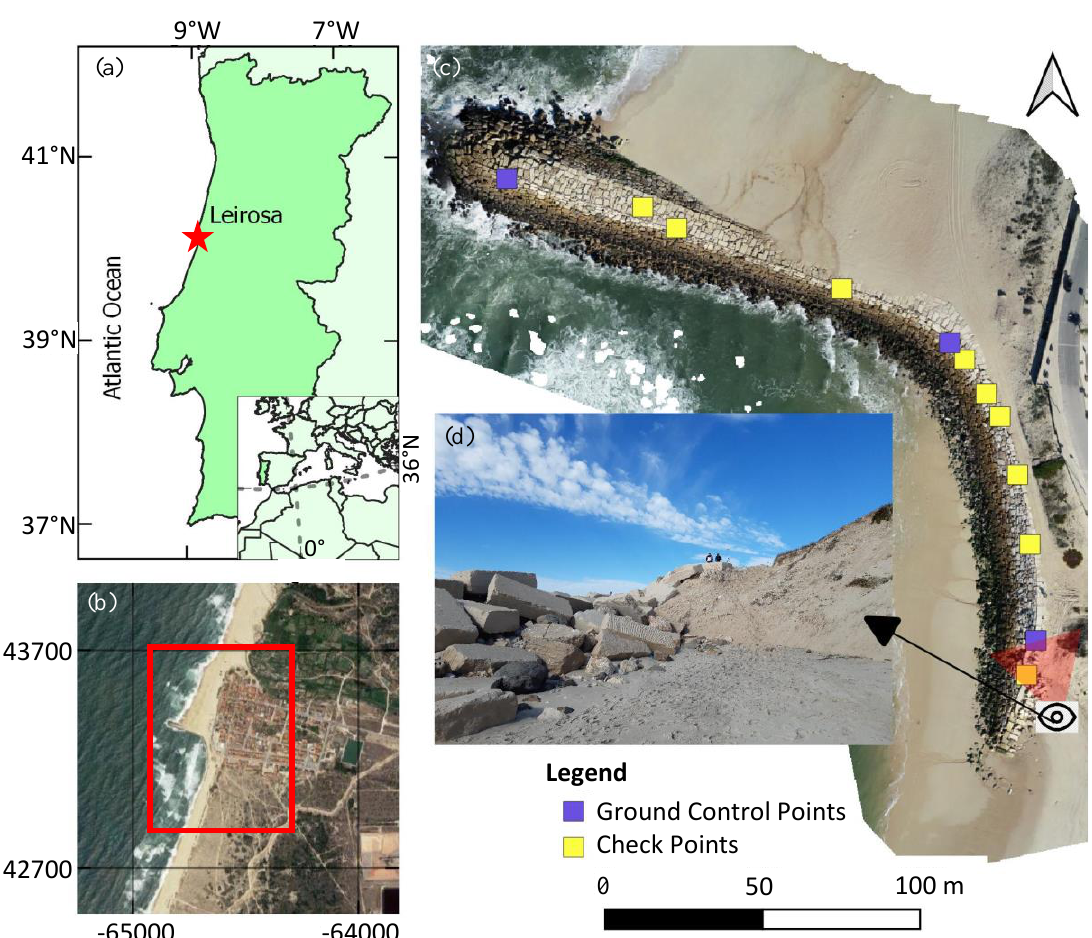
Figure 1. Study area illustration. (a and b) Location of Leirosa Beach in the Portuguese coast (red star in (a) and red rectangle in (b)). (c) Orthophoto generated by drone survey of Leirosa groin. The colorized squares represent the control points used in the photogrammetric process. (d) Photo of the south groin head showing several blocks